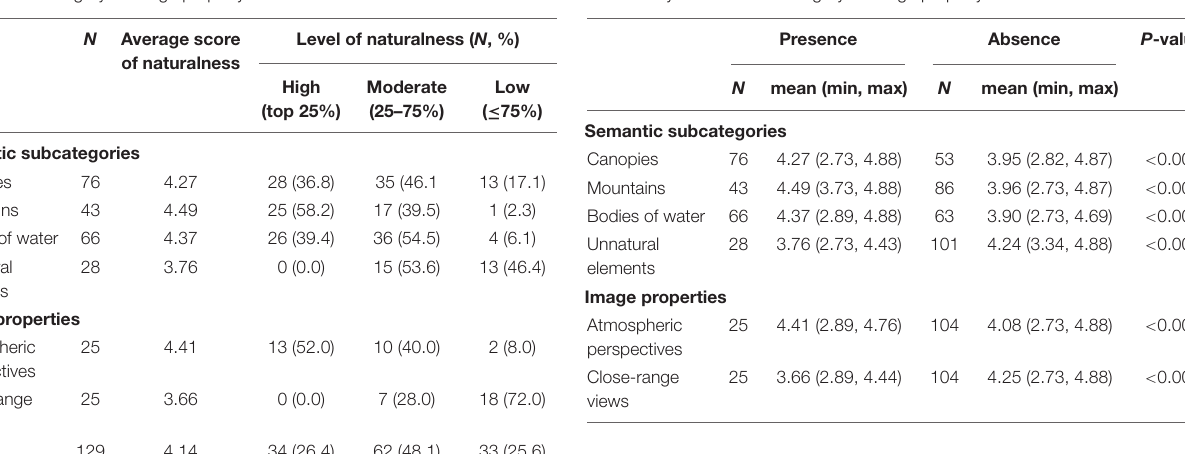
TABLE 2 | Average scores of naturalness ratings and levels of naturalness by semantic subcategory or image